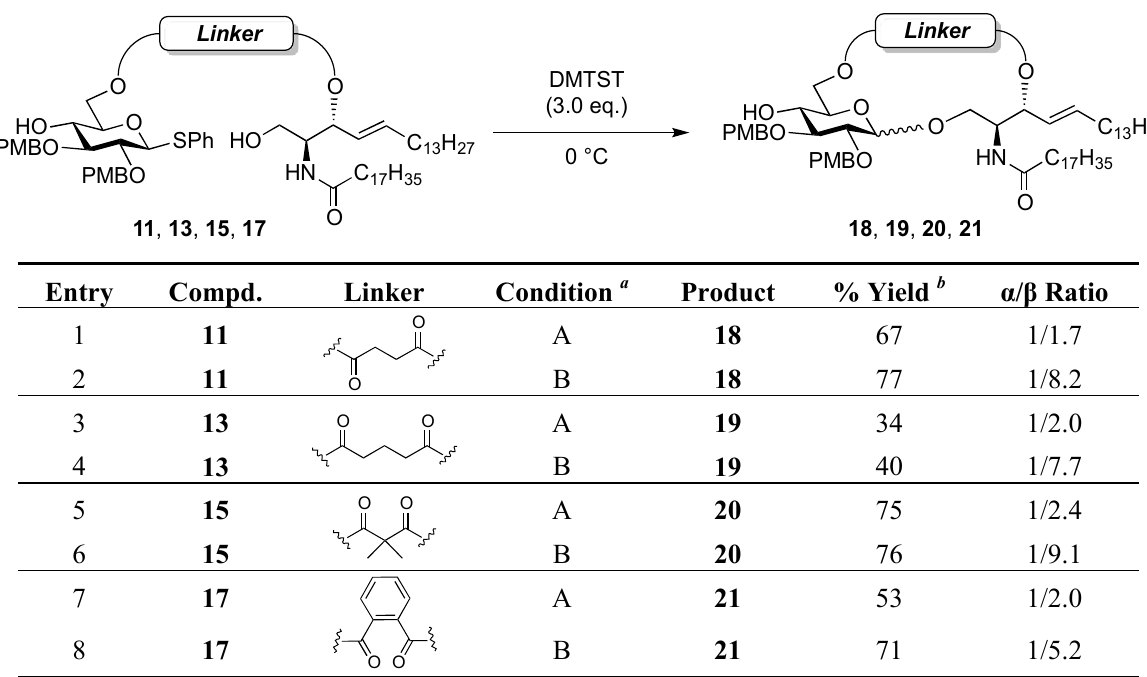
Table 1. Investigation into the effect of various linkers on intramolecular glycosylation.